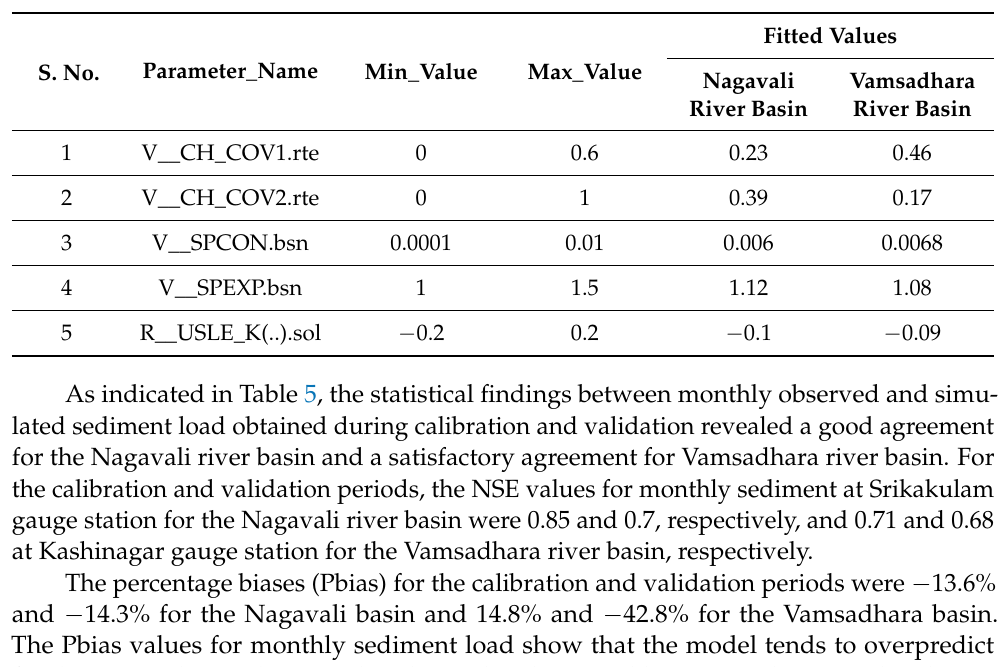
Table 6. Calibrated parameters and their fitted values for monthly sediment simulation.